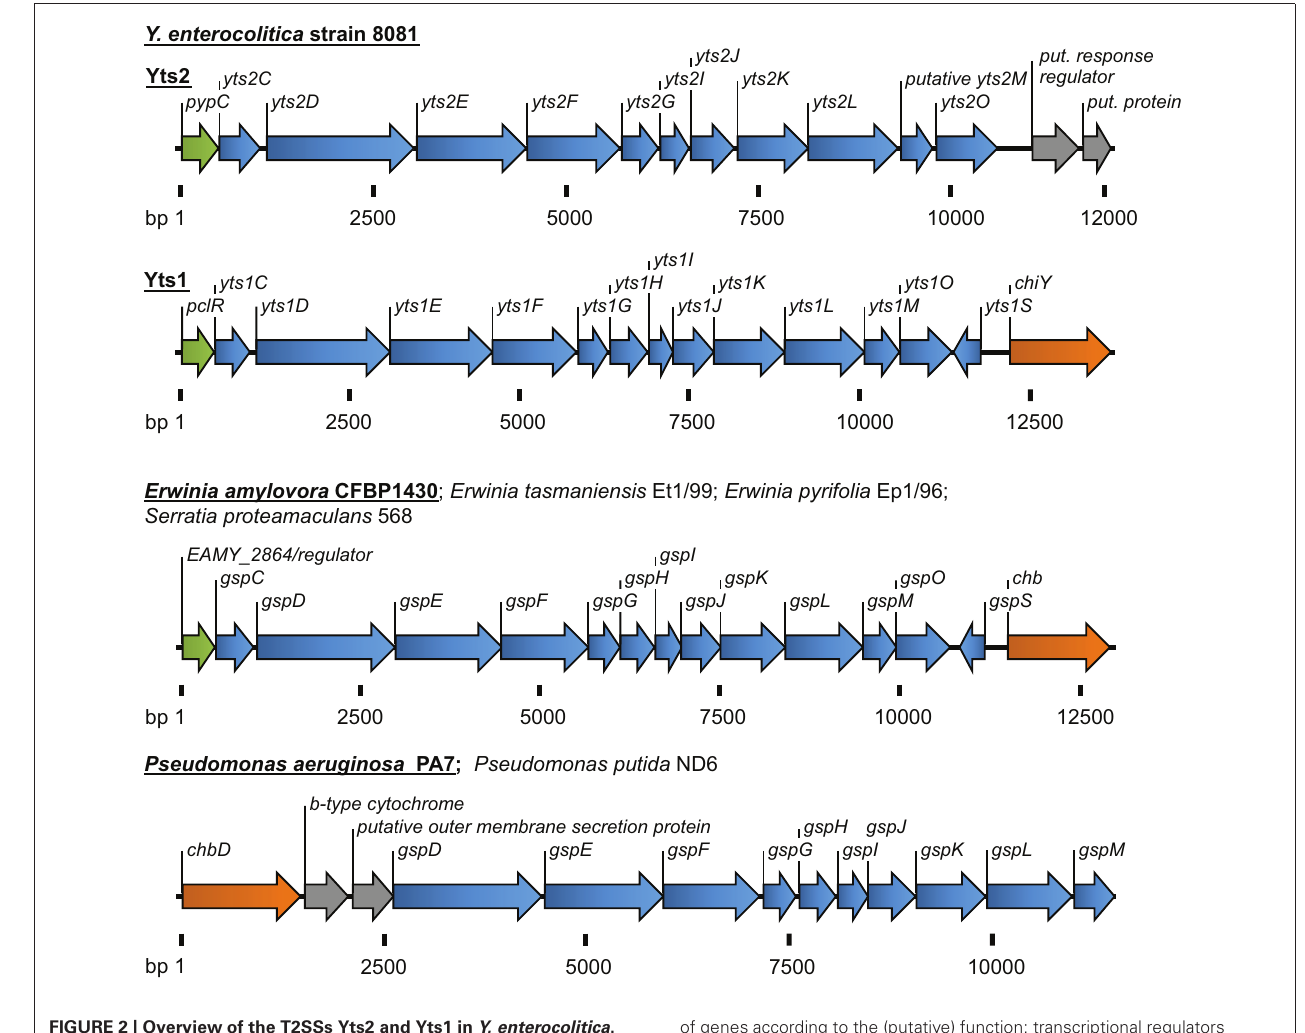
of genes according to the (putative) function: transcriptional regulators (green), T2S components (blue), carbohydrate-binding molecules (orange), b-type cytochrome and proteins with unknown function